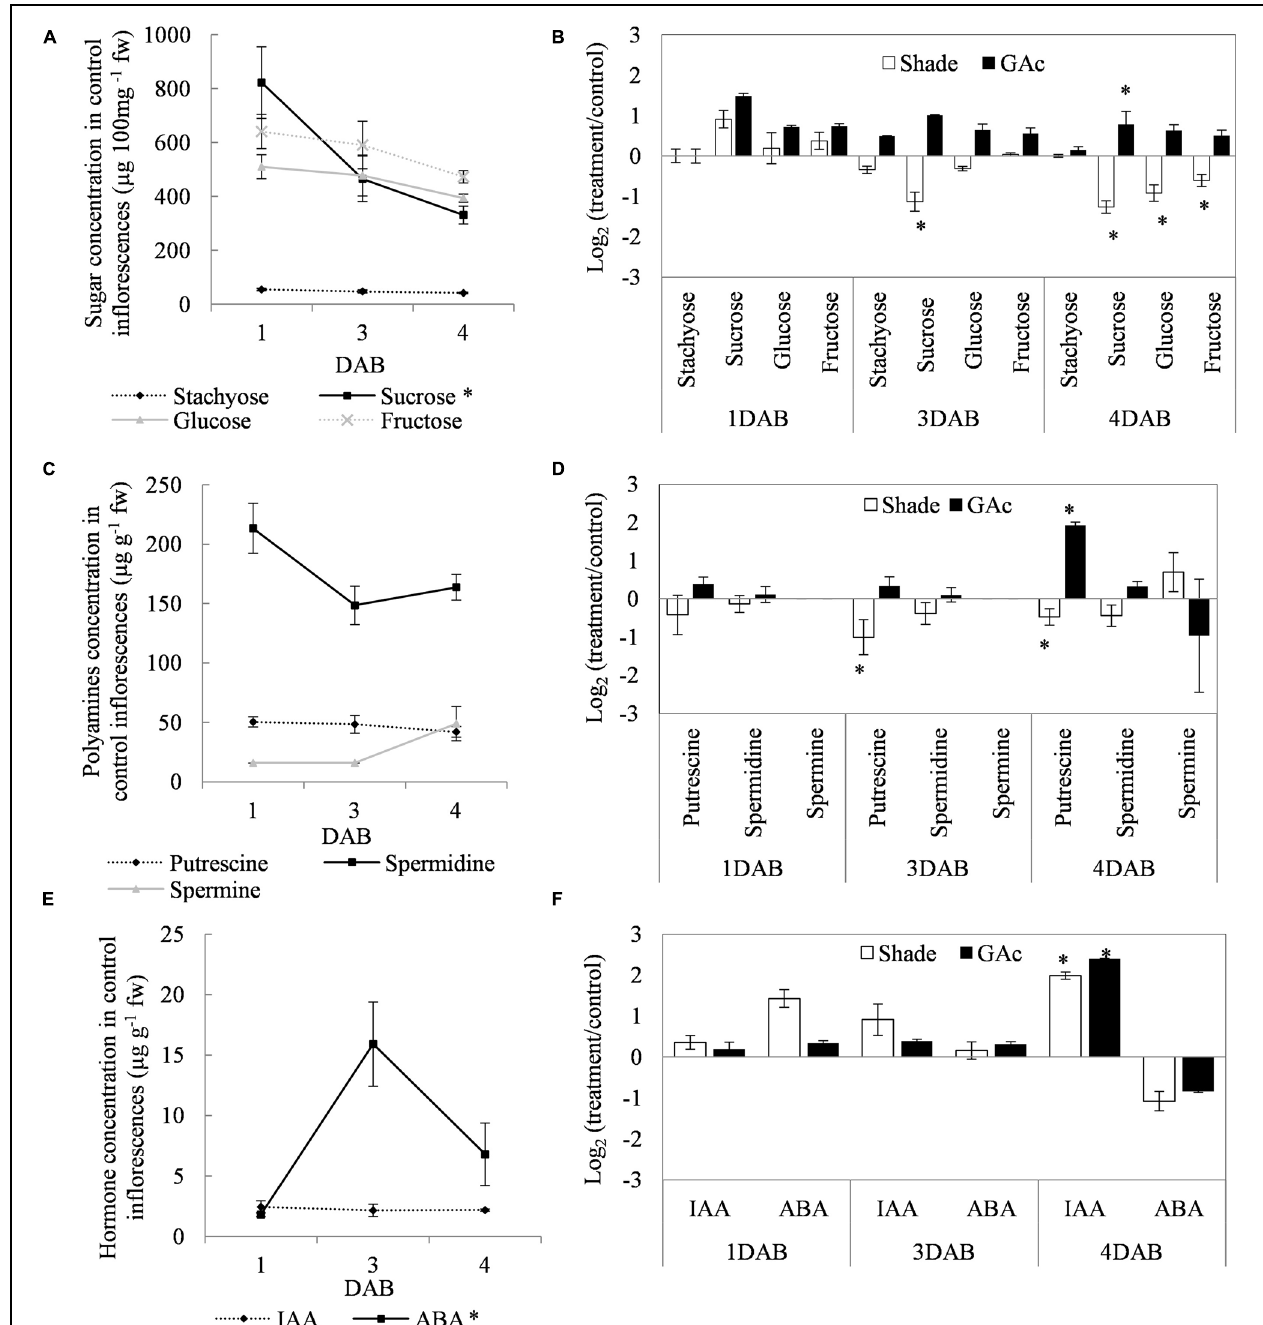
4 DAB. Statistical significances of different time points in metabolites concentration in control inflorescences, and of treatments comparing to control were assessed by one-way ANOVA ( ∗ mean significantly different at P < 0.05).